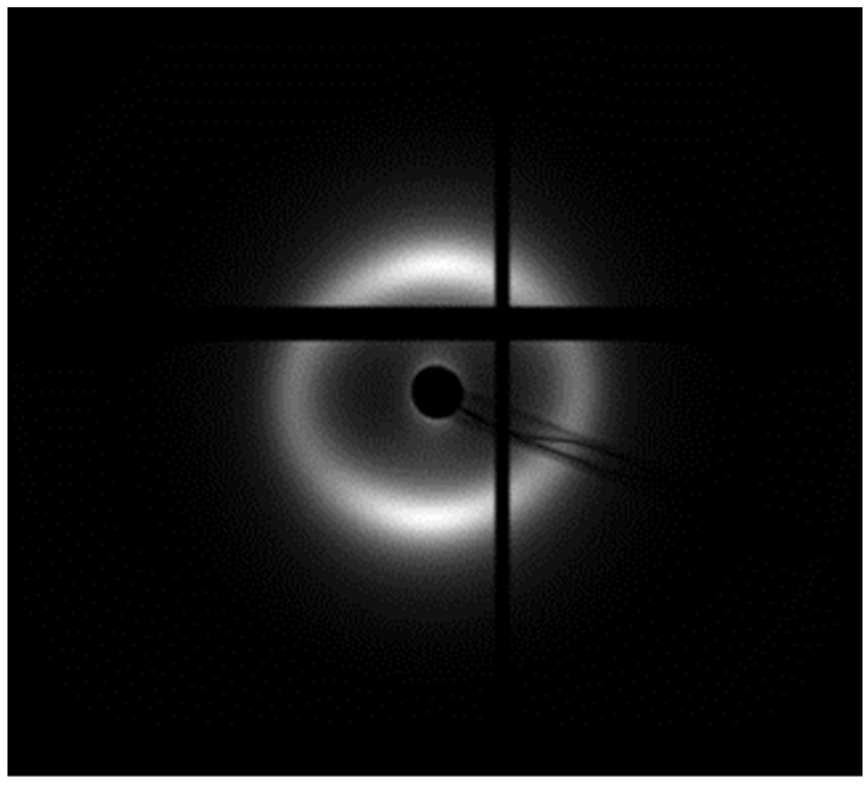
Figure 8. Example of a small-angle diffraction pattern from pig corneal stroma produced by collagen obtained in the Pilatus detector.